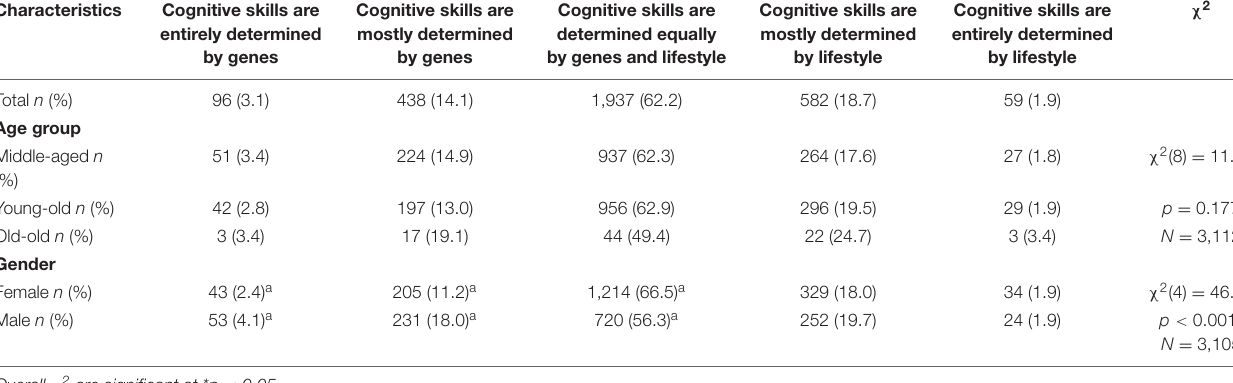
TABLE 1 | Respondents’ opinions about determinants of cognitive skills broken down by age group and gender. Characteristics Cognitive skills are Cognitive skills are Cognitive skills are entirely determined mostly determined determined equally by genes by genes by genes and lifestyle